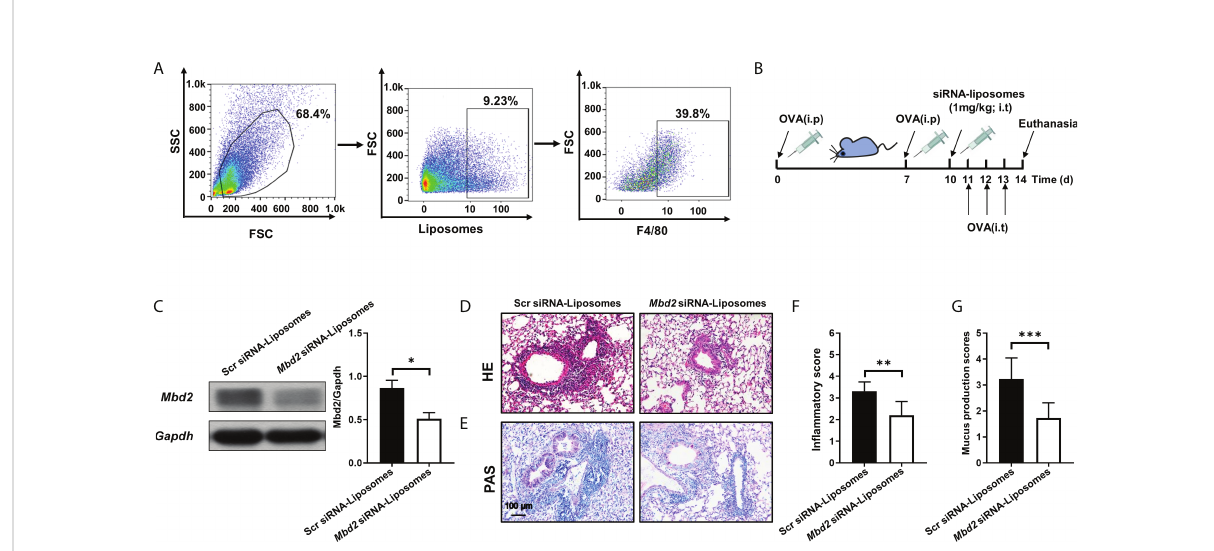
FIGURE 5 Intratracheal injection of Mbd2 siRNA-loaded liposomes protected mice from OVA-induced allergic airway in fl ammation. (A) : Flow cytometry analysis of the liposome distribution in the lungs of mice after 3 days of OVA challenge. (B) : Schematic of the experimental design and timeline of OVA-treated WT mice transfected with either scrambled or Mbd2 siRNA-loaded liposomes. (C) : Western blot analysis of Mbd2 expression in lung homogenates. Left panel: Representative Western blot results. Right panel: Bar graph showing the expression levels of Mbd2 in all mice of each group examined. (D) : H&E staining for the analysis of lung in fl ammation. E : PAS staining for the analysis of mucus hypersecretion. (F-G) : Bar graphs represent the quantitative mean score of the severity of in fl ammation (F) and mucus production (G) . the images were taken at ×200 magni fi cation. The data were collected from 4-5 mice in each study group. * p < 0.05; ** p < 0.01; ***p <